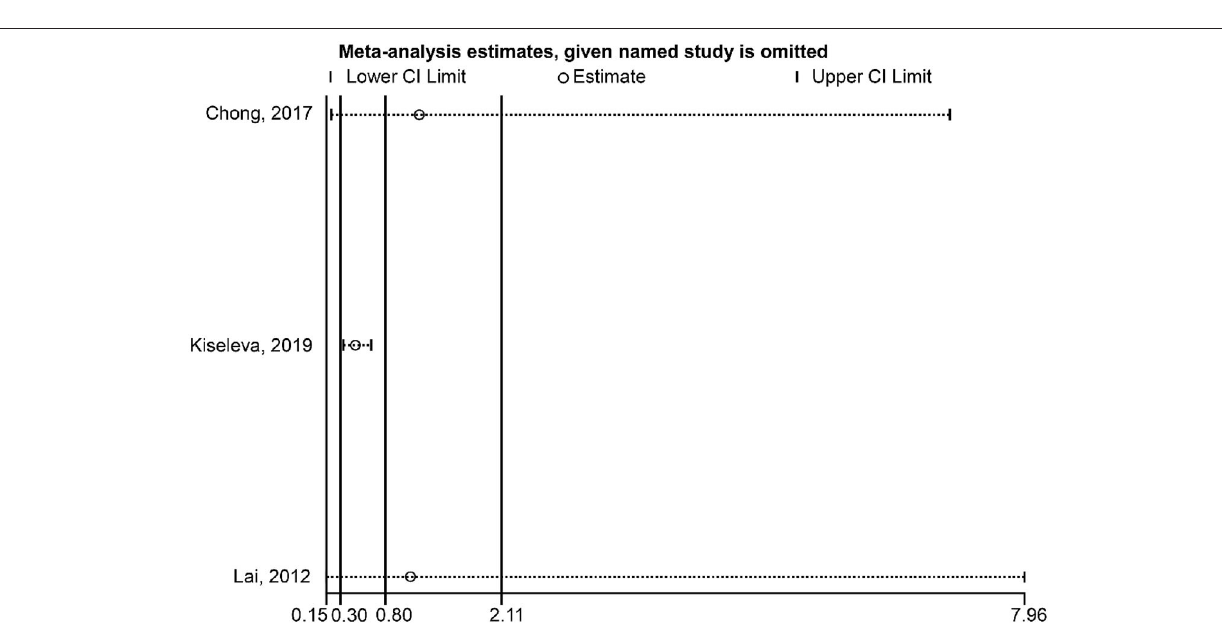
FIGURE 6 | Sensitivity analysis of disease-free survival comparing the human papillomavirus subtype 16 (HPV-16) positive vs. negative